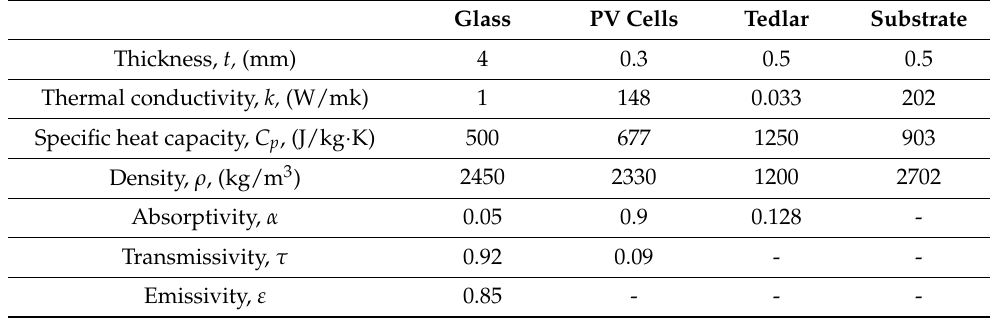
Table 1. Design parameters and thermophysical properties of PV components [4,14]. Glass PV Cells Tedlar Substrate Thickness, t,